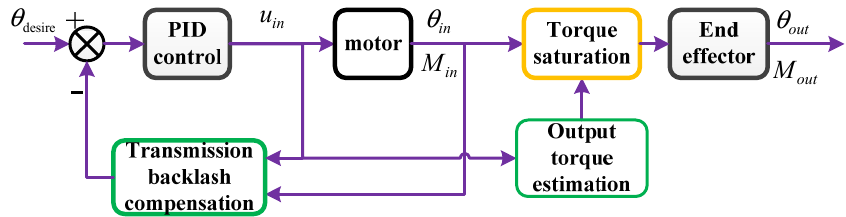
Figure 7. Control flow of the distal grasper of the cable-pulley system.